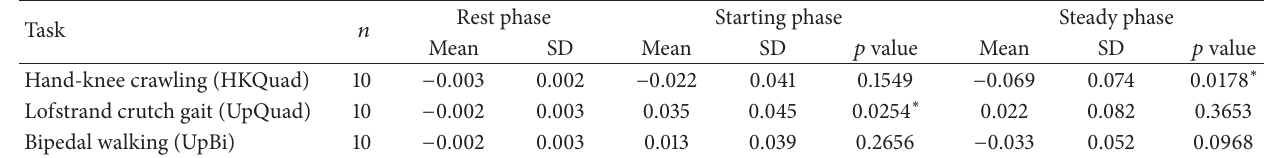
Table 1: Oxy-Hb of SMA for each task. Mean and SD of 10 participants (unit: mmol/l × mm).